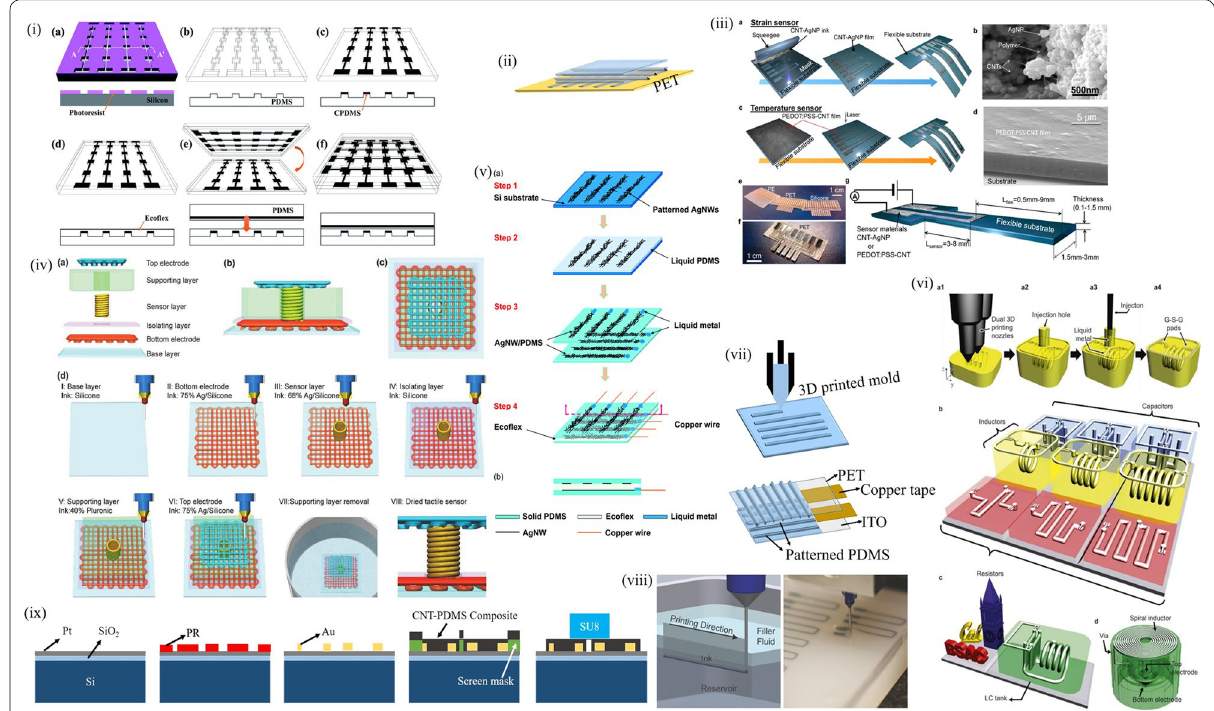
Fig. 8 Printed technology in sensor fabrication (i) Micropatterned CNT upon microstructured PDMS layer (Reproduced by permission from [165] Copyright 2014, Royal Society of Chemistry ) (ii) Direct printing of electrode layers. (iii) Whisker pattern printing of electrode (Reproduced by